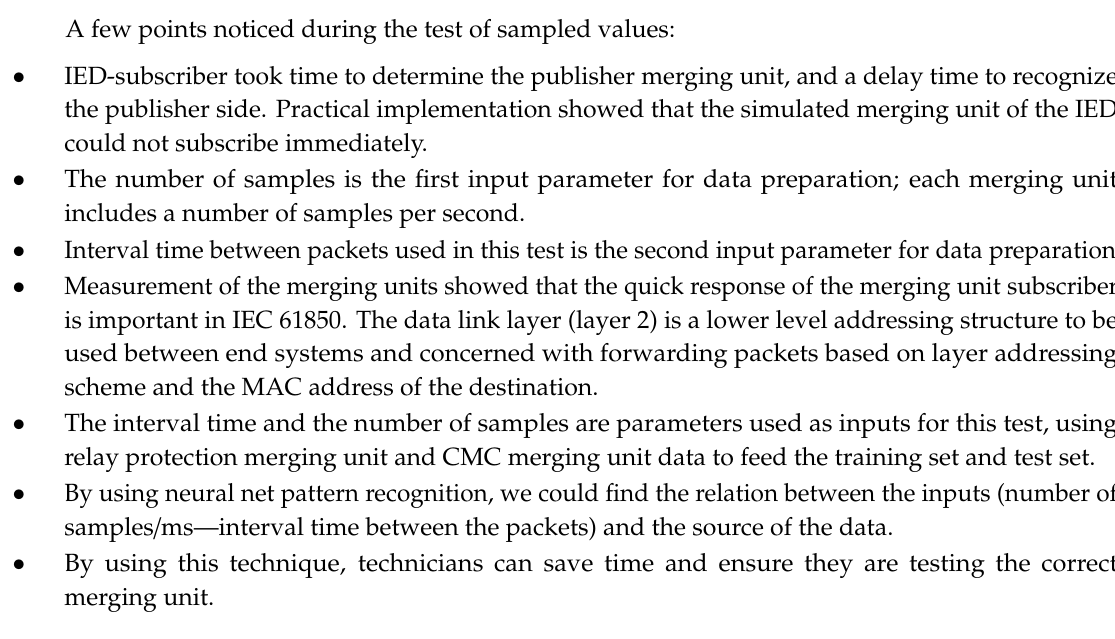
Table 7. Training set and test set.